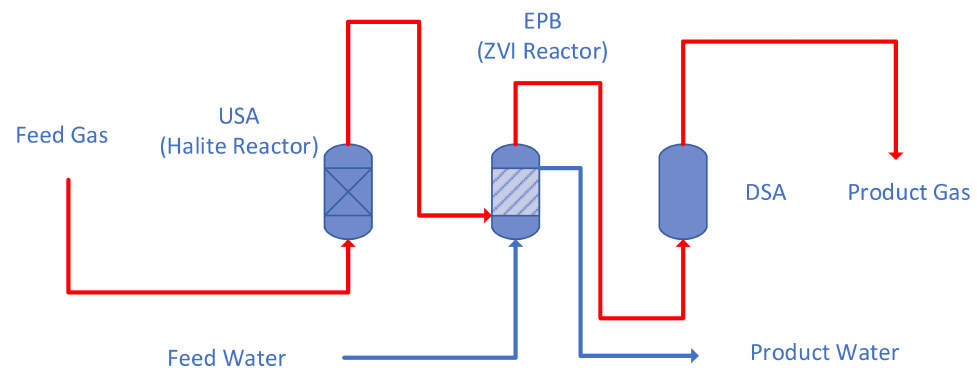
Figure 1. Desalination associated with the ZVI Pellets. Feed water salinity = 9.24 g NaCl L − 1 . Five 1 L, static water bodies, 8 cm water depth, with an air-water contact. Each water body, contained 5 × 15 mm O.D. Cu 0 pellets produced using 8.8 g NaCl L − 1 in the ZVI Reactor. The pellets contained about 25 g L − 1 of ZVI Pellet Material + about 25 g L − 1 of Cu 0 sheathing. ( a ) Salinity vs. hours on line; ( b ) Desalination vs. hours on line.